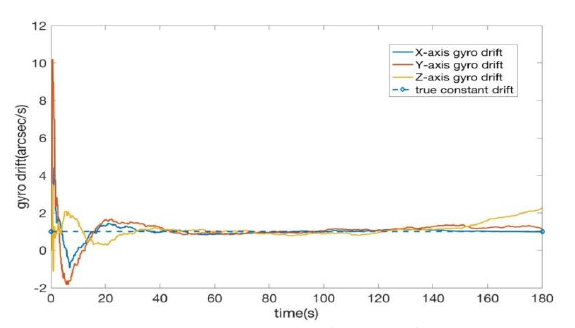
Figure 4. The estimation of gyro drift based on the proposed method